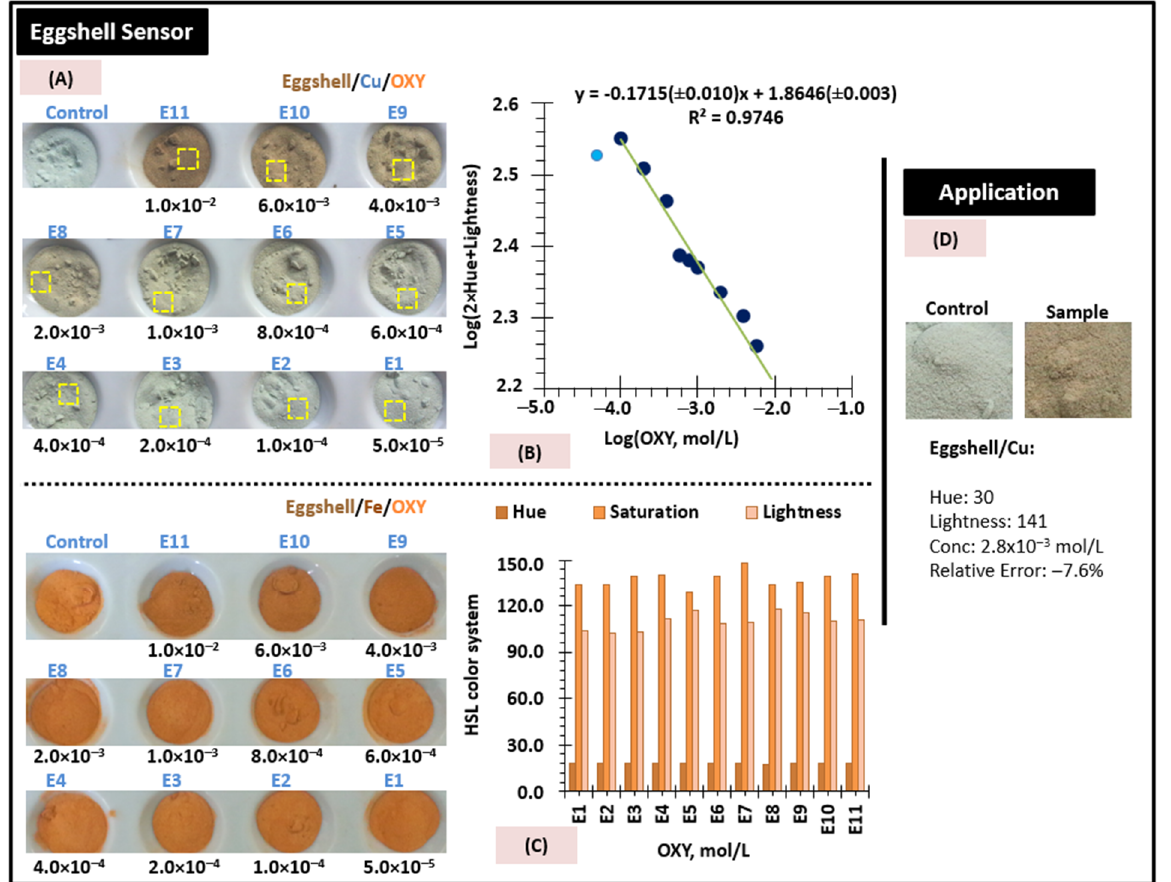
Figure 7. The use of the sensor, including ( A ) visual inspection and comparison with the standards; ( B ) their calibration, showing colour gradient and graphical representation of mathematical transformation of the colour coordinates with the logarithm OXY concentration for the eggshell/Cu sensor; and ( C ) evaluation of HSL colour system for the eggshell/Fe sensor, and ( D ) their application to a spiked water sample.